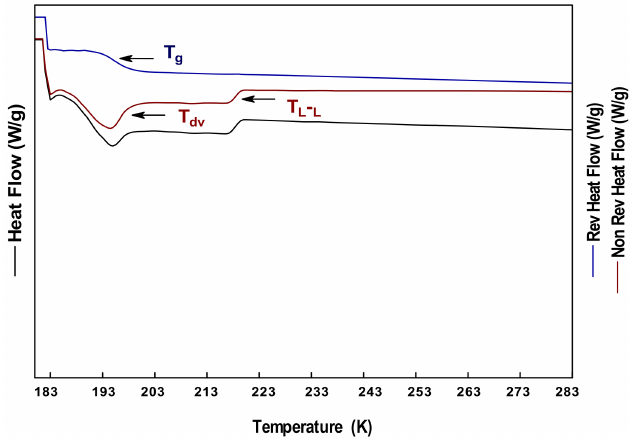
Figure 3. MDSC thermograms of GL at 275